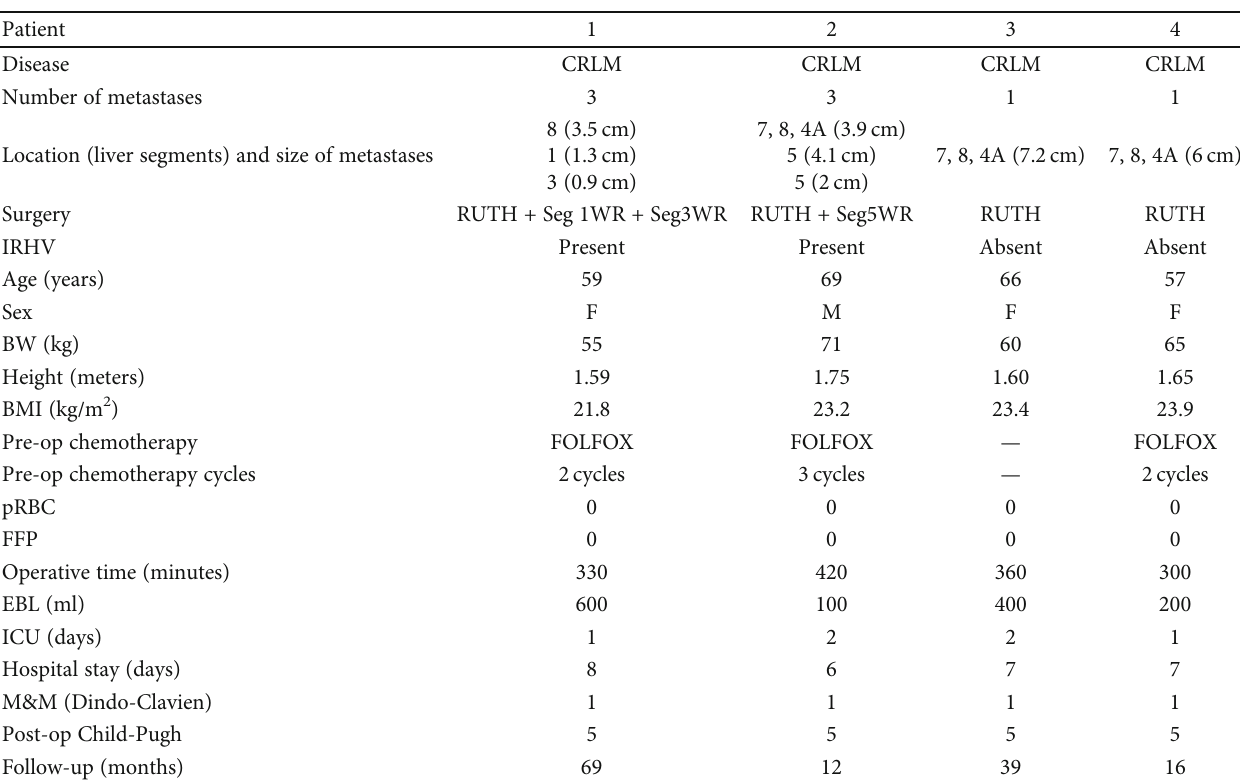
Table 1: Patients ’ clinical